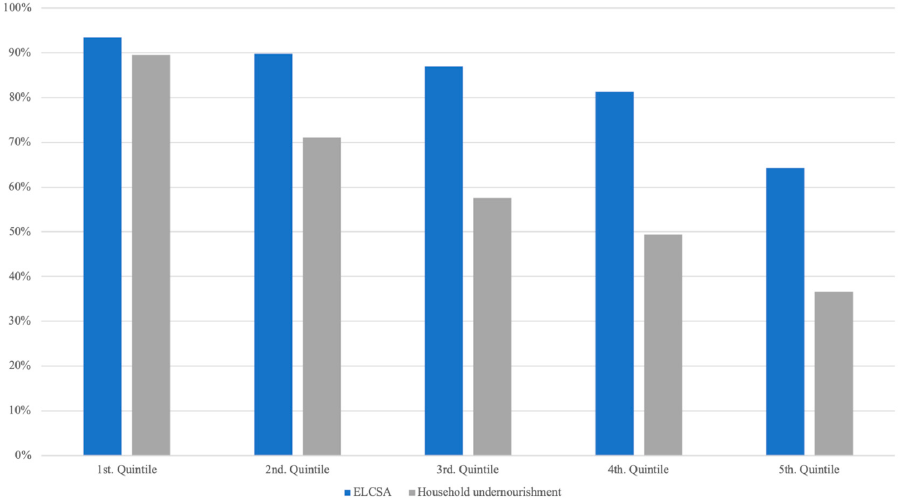
Figure 3. Prevalence of food insecurity across income groups. ELCSA, Latin American and Caribbean Food Security Scale.